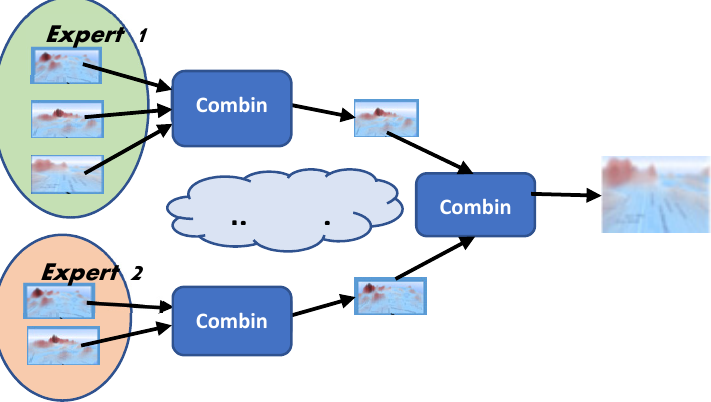
Figure 3. Hierarchical combination process. The figure shows that expert 1 generated three and expert 2 two scenarios individually. Expert 1 produced a single scenario combining the maps generated by her and presenting it to expert 2 for consideration. Expert 2 did the same with her two maps. After a discussion process (which is supported by the developed system) both experts agree to combine their scenarios in a single one, which is used for developing emergency preparedness plans.